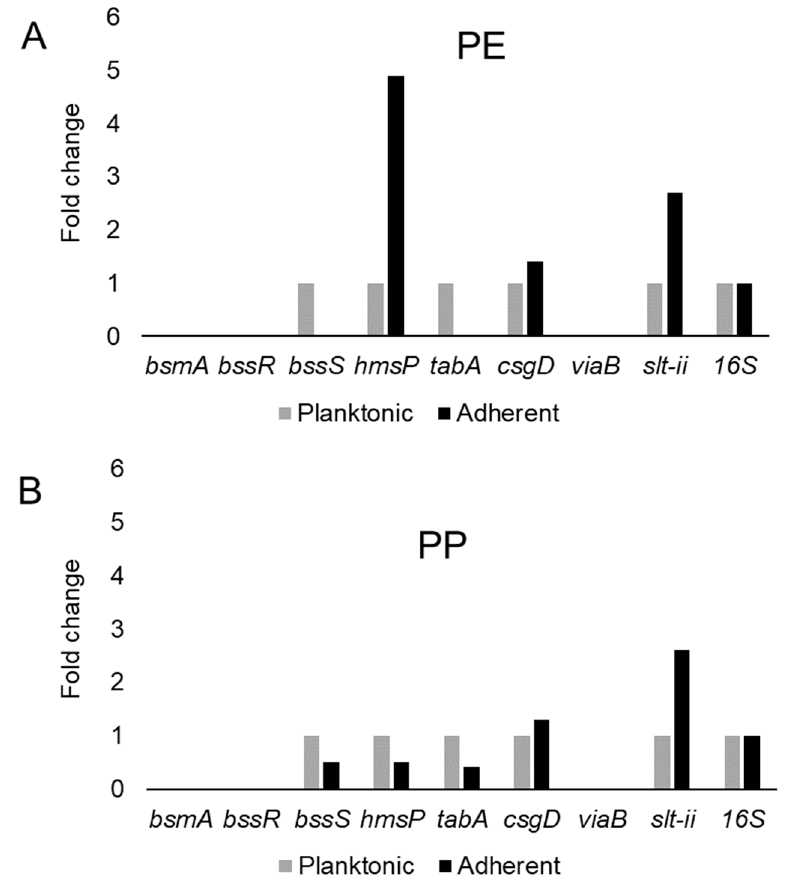
Figure 3. Variation in gene expression during planktonic and adherent growth of A. hydrophila using tryptic soy broth on polyethylene (PE) surface as shown in ( A ) and polypropylene (PP) surface as shown in ( B ), respectively. The 16S rRNA gene expression was used as an internal control.